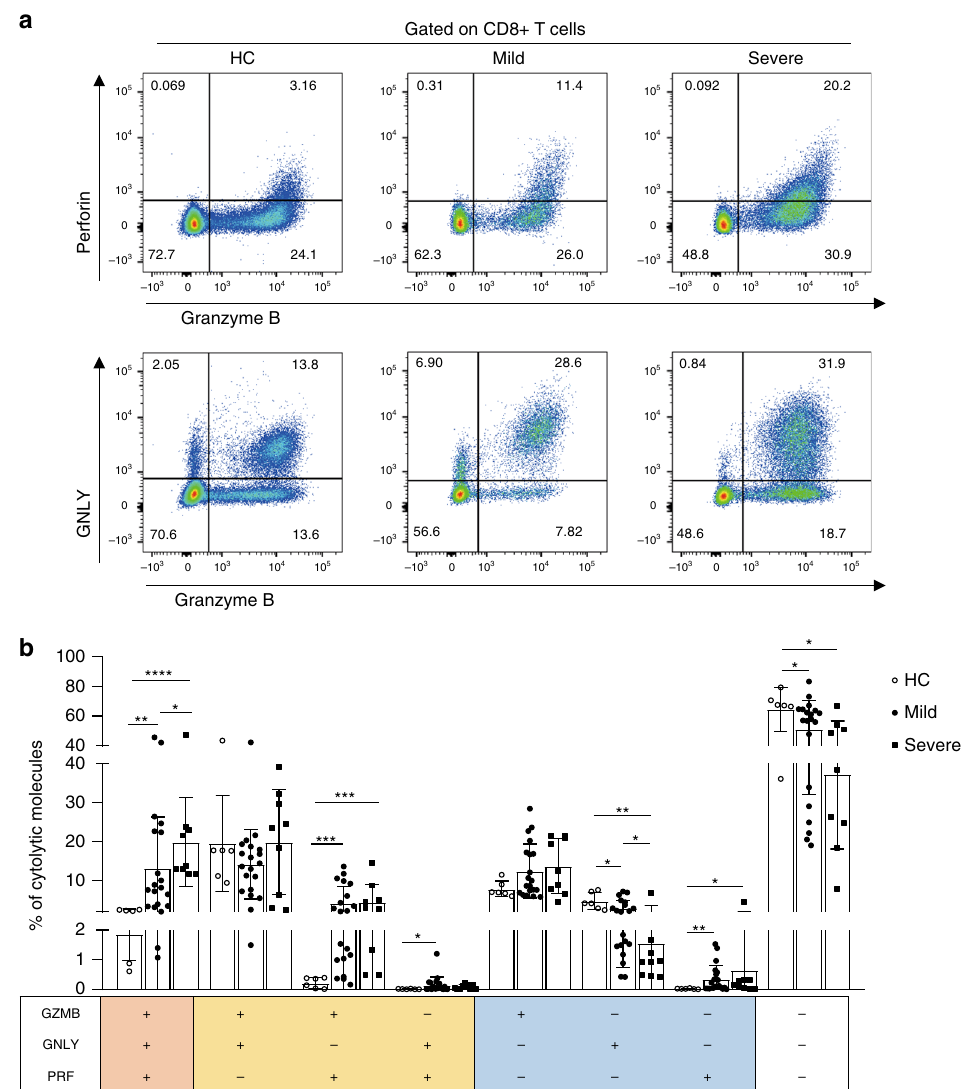
Fig. 4 Co-expression patterns of cytotoxic effectors in CD8 + T cells from SARS-COV-2 infected patients. a , b Cytolytic molecules were assessed by fl ow cytometry, and the proportions of CD8 + T lymphocytes co-expression of GNLY, GZMB, PRF were analyzed in HC ( n = 6), mild ( n = 20), and severe ( n = 9) patients of SARS-COV-2 infection. Data are expressed as mean ± SD. * p < 0.05, ** p < 0.01, *** p < 0.001, **** p < 0.0001 by two-tailed Mann – Whitney U -test for b ( p = 0.002, p = 0.0004, and p = 0.0386 for GZMB + GNLY + PRF + cells, p = 0.0006 and p = 0.0004 for GZMB + GNLY-PRF + cells, p = 0.0459 for GZMB-GNLY + PRF + cells, p = 0.0331, p = 0.0048, and p = 0.03 for GZMB-GNLY + PRF − cells, p = 0.0026 and p = 0.0496 for GZMB-GNLY-PRF + cells, and p = 0.0279 and p = 0.012 for GZBM-GNLY-PRF − cells, respectively). Source data included as a Source Data